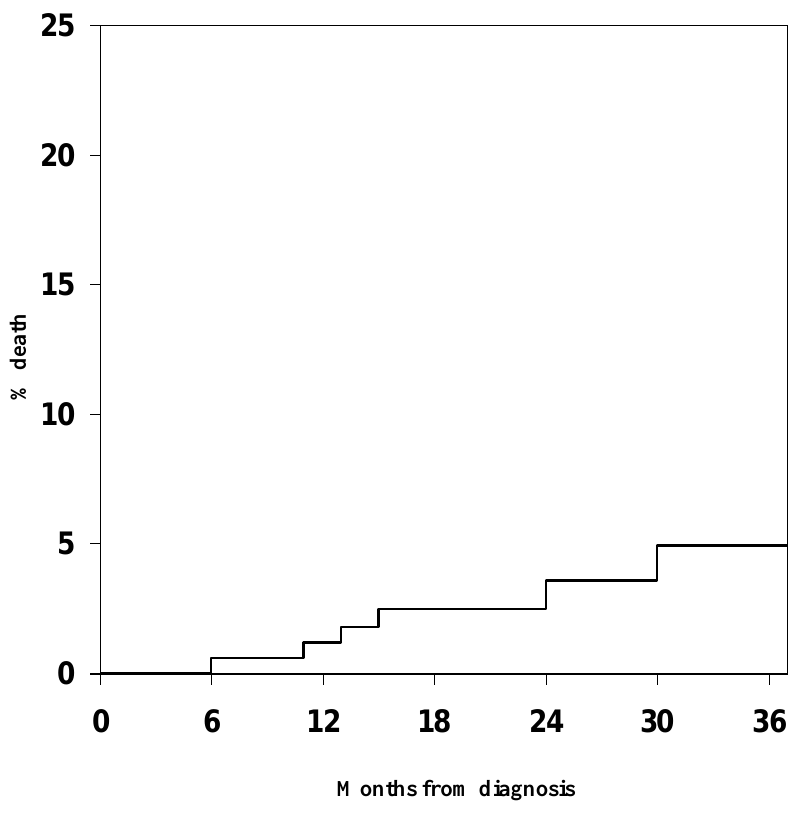
FIGURE 1. Actuarial risk of early non–prostate-cancer-related death after diagnosis of localized or locally advanced prostate cancer (Kaplan-Meier analysis, six